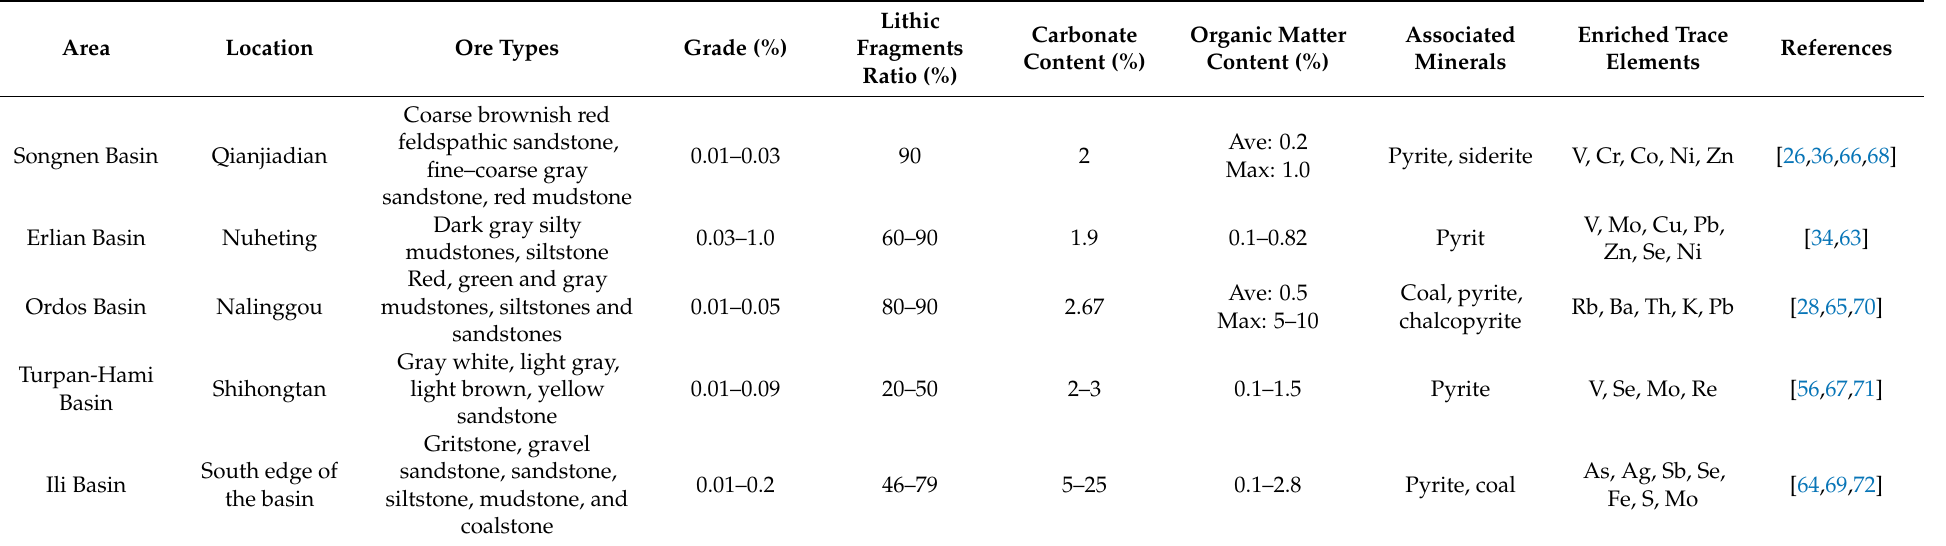
Table 2. Geochemical baselines of representative ore belts in each